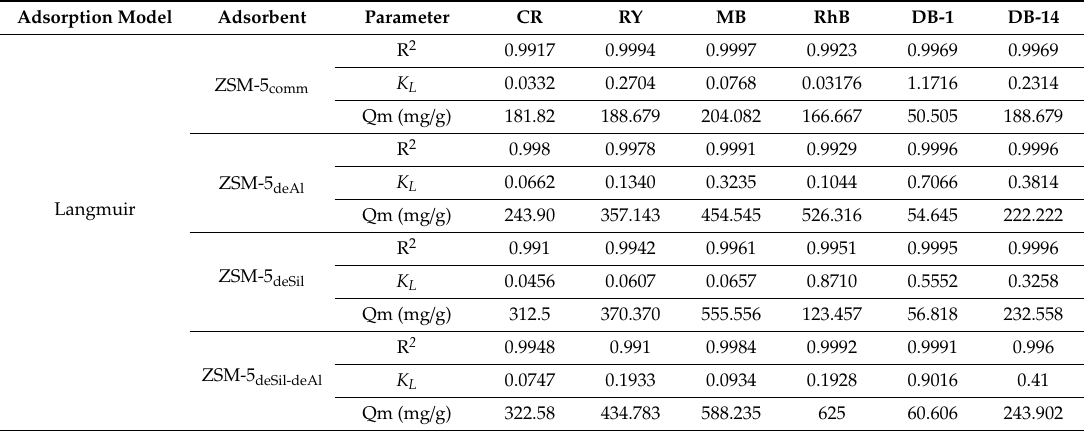
Table 3. Dyes isotherm adsorption